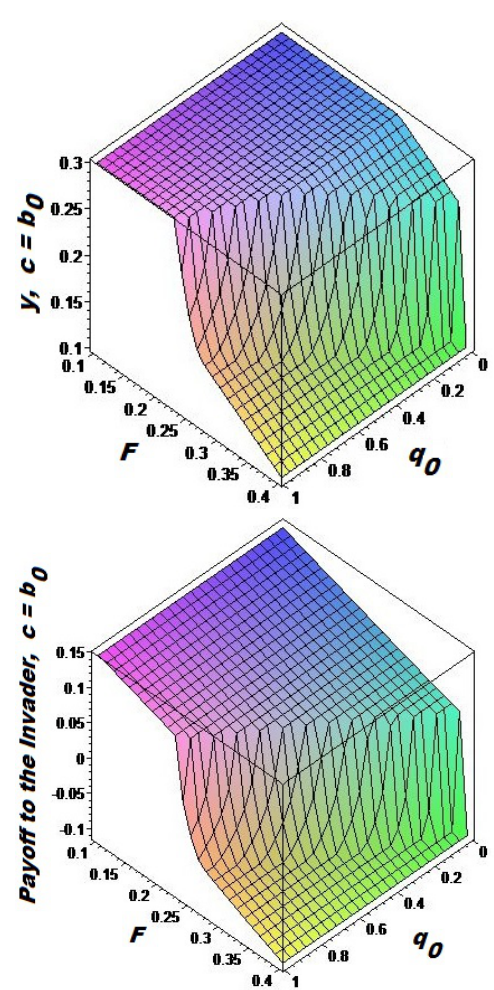
Figure 3. Equilibrium strategy y (upper) and payoff (bottom) to the Invader for c = b 0